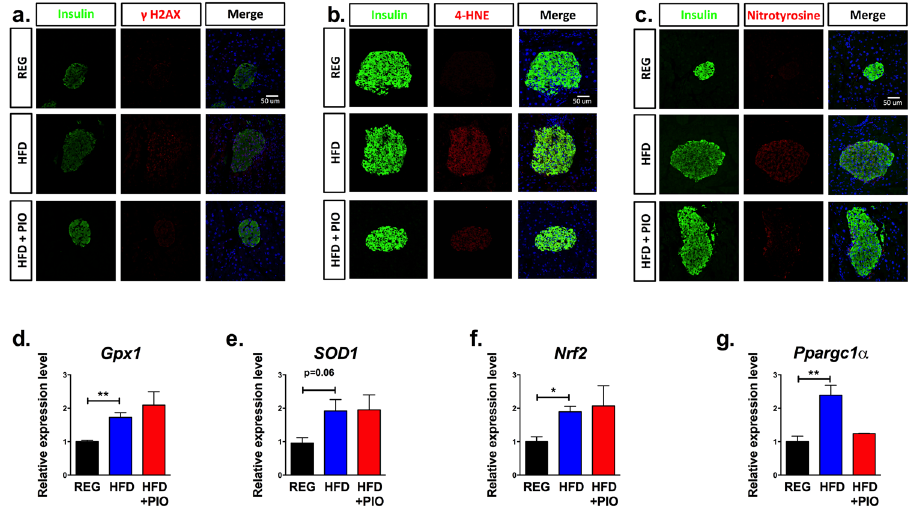
Figure 5. Evidence of DNA damage and oxidative stress in islets from HFD treated mice. ( a ) Representative immunofluorescent staining of γ H2AX, insulin, and DAPI for islets from each treatment group. ( b ) Representative immunofluorescent staining of 4-hydroxynonenal (4-HNE), insulin, and DAPI for islets from each treatment group. ( c ) Representative immunofluorescent staining of nitrotyrosine, insulin, and DAPI for islets from each treatment group. ( d – g ) qRT-PCR analysis of total islet RNA for antioxidant genes, including Gpx1, SOD1, Nrf2 , and Ppargc1 α . (n = 3) * p < 0.05, ** p <